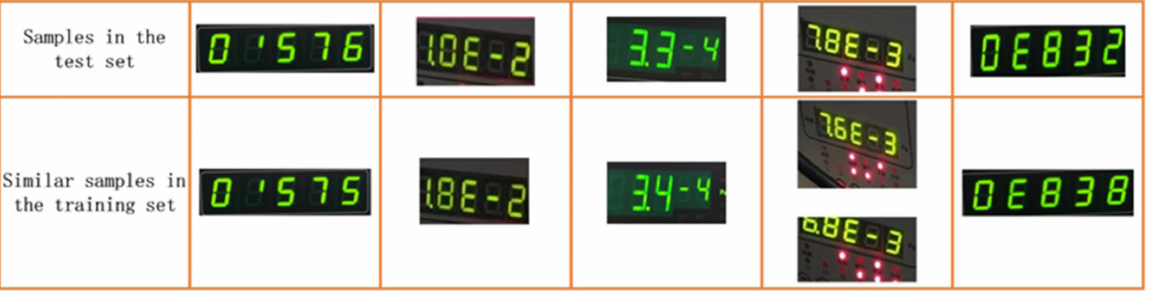
Figure 8. Some examples of memorial errors.